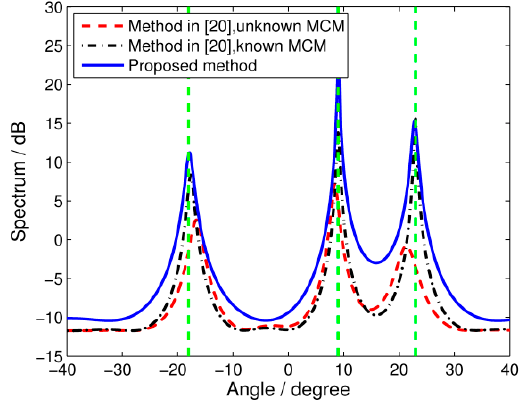
Figure 2. Spatial spectrums of wideband DOA estimation. SNR = 5 dB, snapshots = 100.